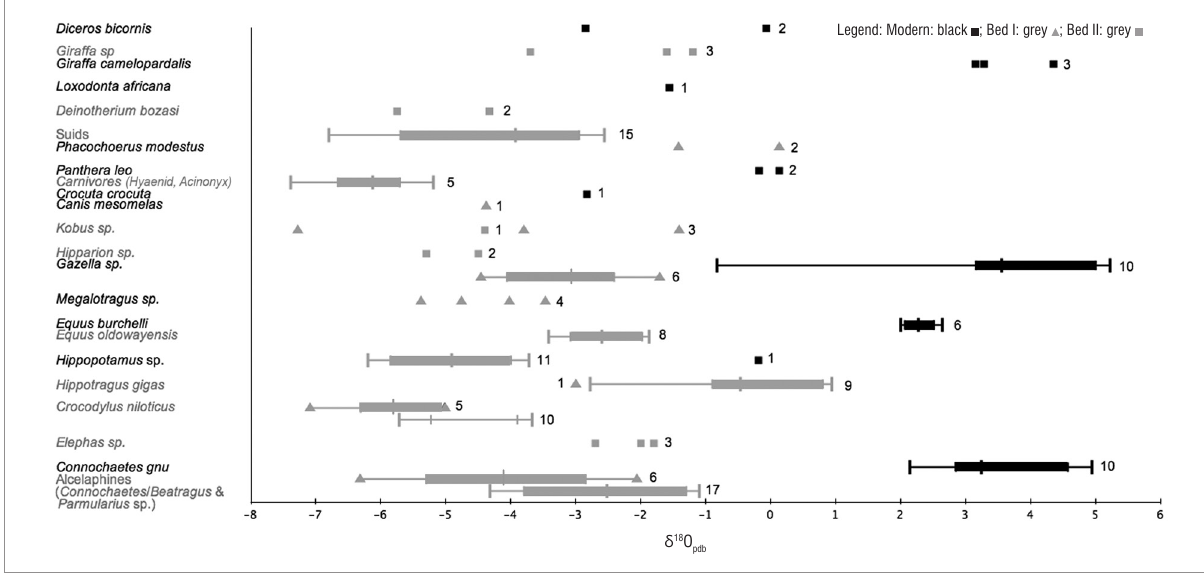
Figure 5: δ 18 O from tooth enamel of modern fauna from the Serengeti (in black) and from fossil fauna from Olduvai Beds I and II at ca 1.8 Ma (in